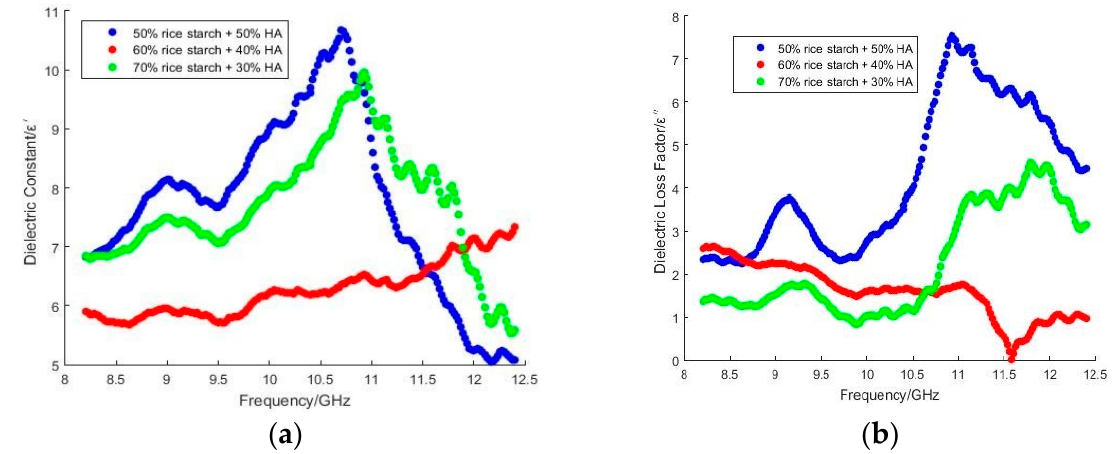
Figure 1. Variations in ( a ) ε′ and ( b ) ε″ over frequency (X-band) with various proportions of rice starch and nHA.